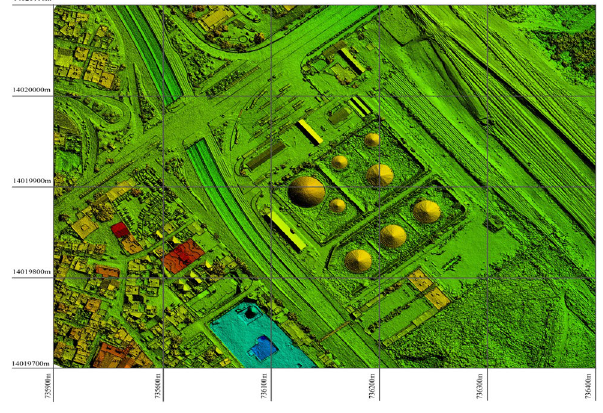
Fig. 1. 3-D capture by UAV DATA